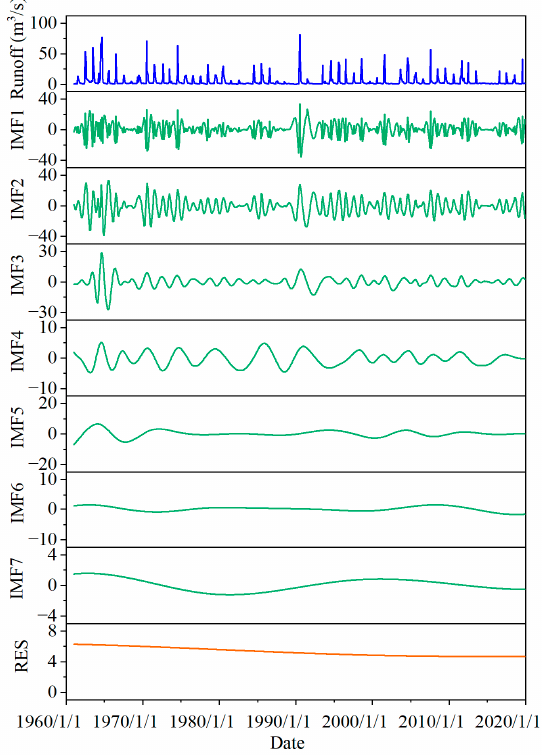
Figure 14. The decomposition results of the CEEMDAN method for runoff at Laiwu station.